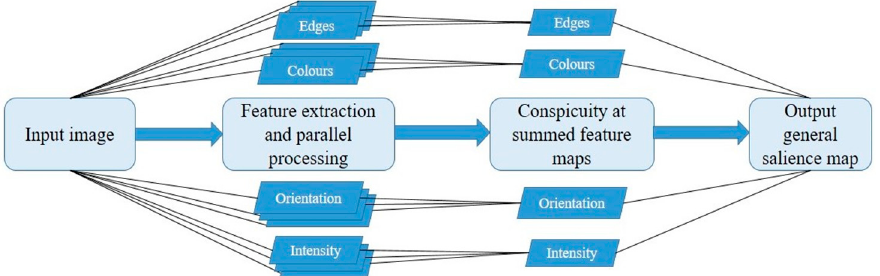
Figure 1. This figure is a demonstration of the salience computation algorithm present in many existing models meant to provide a general idea of the main steps required for bottom-up salience computation. In the current example, basic features like edges, colour, orientation and intensity are included, though the initial Itti and Koch model focused on three main channels: intensity, orientation and colour. Many implementations of the model take into account other features like edges, motion, junctions, shades, etc. Some implementations also include an additional temporal stage that computes fixation locations with a mechanism like inhibition of return (IOR) to prevent fixations at previously attended locations. The main steps present in the figure are as follows: (1) A model receives an input image; (2) features of the image are extracted and organized in a hierarchical manner, with separate feature channels consisting of several levels based on the scale of processing (usually features are downscaled). The features are extracted to individual feature maps using parallel processing, which means that separate feature channels are analysed simultaneously in parallel; (3) the feature maps extracted at every level are merged into one general feature map organized per feature, with the most conspicuous locations reflected on the maps; and (4) the resulting feature maps are combined into a single map of conspicuity, which is the output of the model in the form of a so-called salience map.